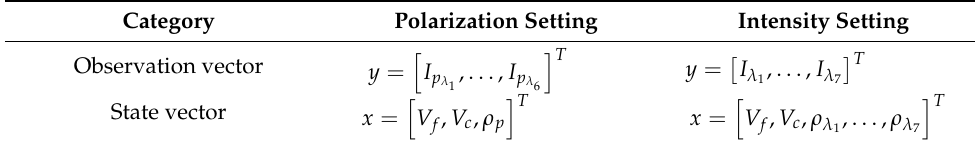
Table 2. State vector x and observation vector y